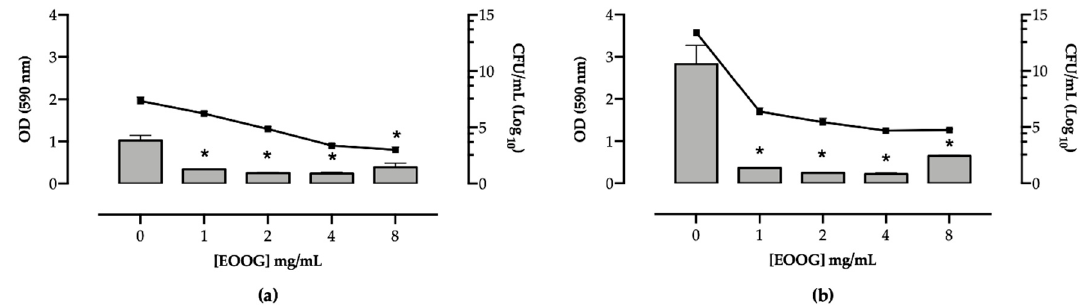
Figure 3. Antibiofilm activity of different concentrations of EO of Ocimum gratissimum L. against preformed biofilms of S. aureus 5B ( a ) and E. coli P12 ( b ), respectively. Biomass quantification by crystal violet staining (OD 590 nm, bars) and cell enumeration by colony count (log 10 CFU/mL, lines). * Statistically different by ANOVA ( p < 0.01) compared to untreated cells.